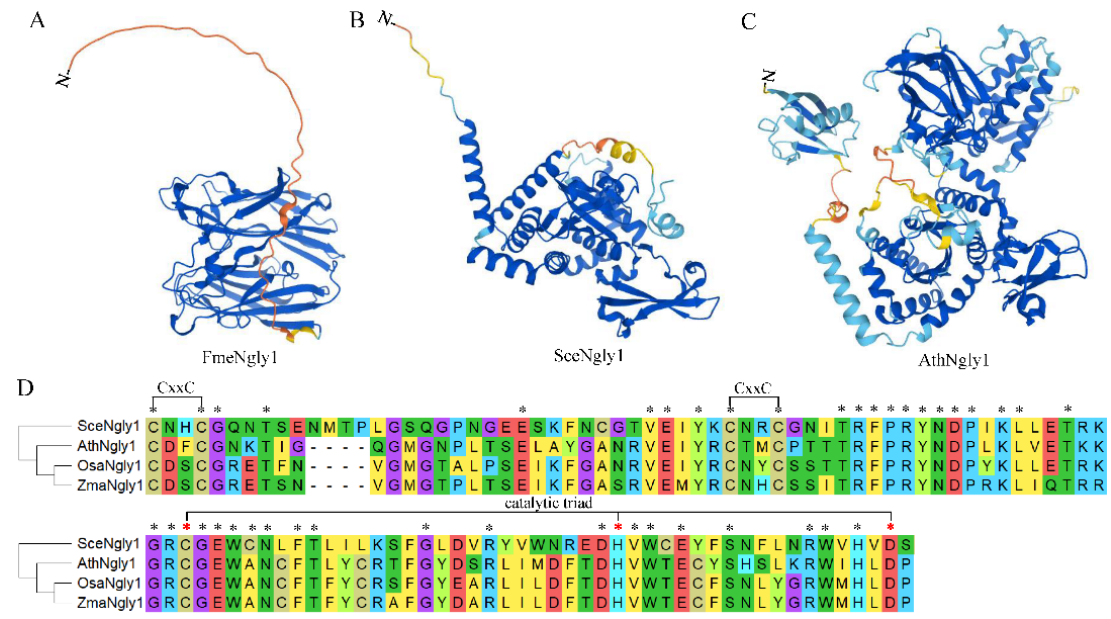
Figure 2. Predicted structures for non-animal Ngly1 and the core transglutaminase-like domain. ( A ) AlphaFold predicted structure of FmeNgly1; ( B ) AlphaFold predicted structure of SceNgly1; ( C ) AlphaFold predicted structure of AthNgly1; ( D ) Sequence alignment of the core transglutaminase-like domain. Fme, Flavobacterium meningosepticum; Sce, Saccharomyces cerevisiae; Ath, Ara- bidopsis thaliana; Osa, Oryza sativa Japonica; Zma, Zea mays; ∗ represents conserved residuals; red ∗ represents the three residuals of the catalytic triad.